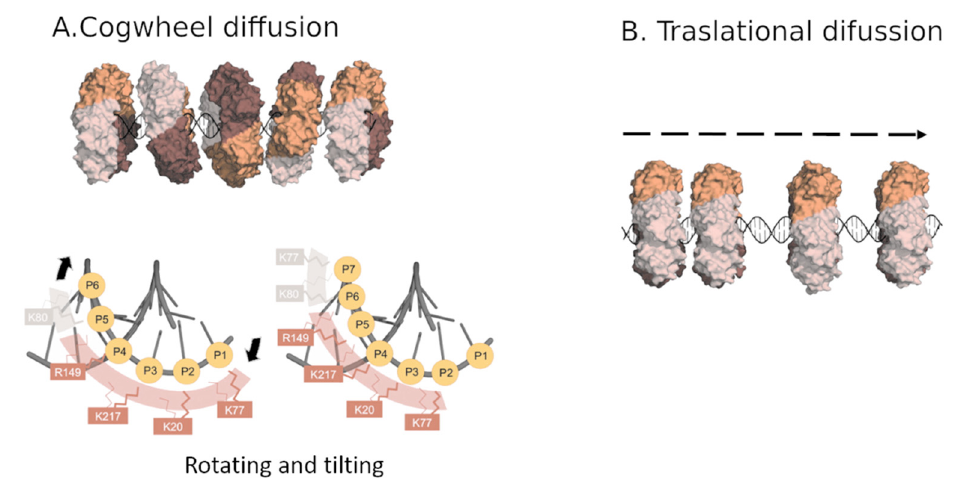
Figure 3. Human PCNA sliding along DNA. ( A ) Cogwheel diffusion mode: PCNA rotation tracks the DNA through a spiral motion, establishing transient interactions with DNA, which keeps the orientation of the clamp invariant relative to the DNA. The threefold rotation axis of PCNA around the DNA helical axis. In the lower panel, the evolution of PCNA–DNA contacts during cogwheel sliding is illustrated. Interacting side chains can rapidly and randomly switch between adjacent phosphates (indicated by the thin and thick lines), enabling PCNA to advance along the phosphate backbone by rotating and tilting motions. ( B ) Translational diffusion mode: PCNA travels along the DNA, without contacting the DNA. (Figure adapted from [28]).